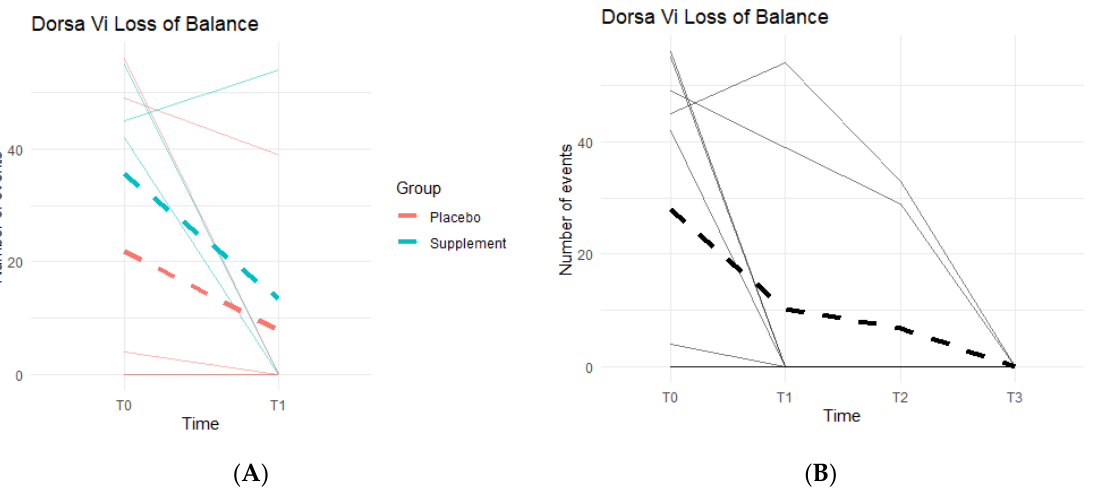
Figure 10. LOB Changes Over Time. DorsaVi LOB events were graphed on a plot. ( A ) compares Supplement vs. Placebo results from T0 to T1. ( B ) shows averages for the entire cohort as a whole at times T0, T1, T2, and T3.